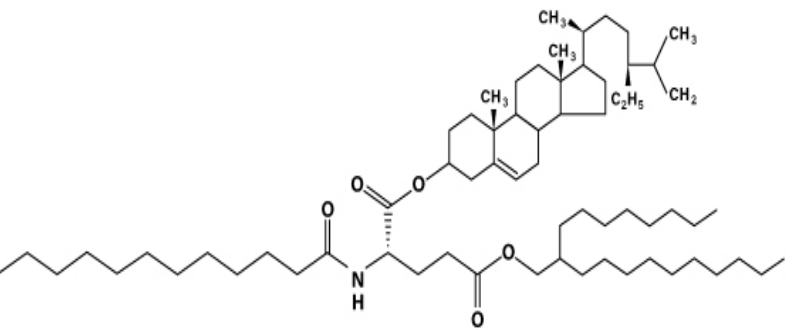
Figure 11. Chemical structure of phytosteryl/octyldodecyl lauroyl glutamate (POLG).